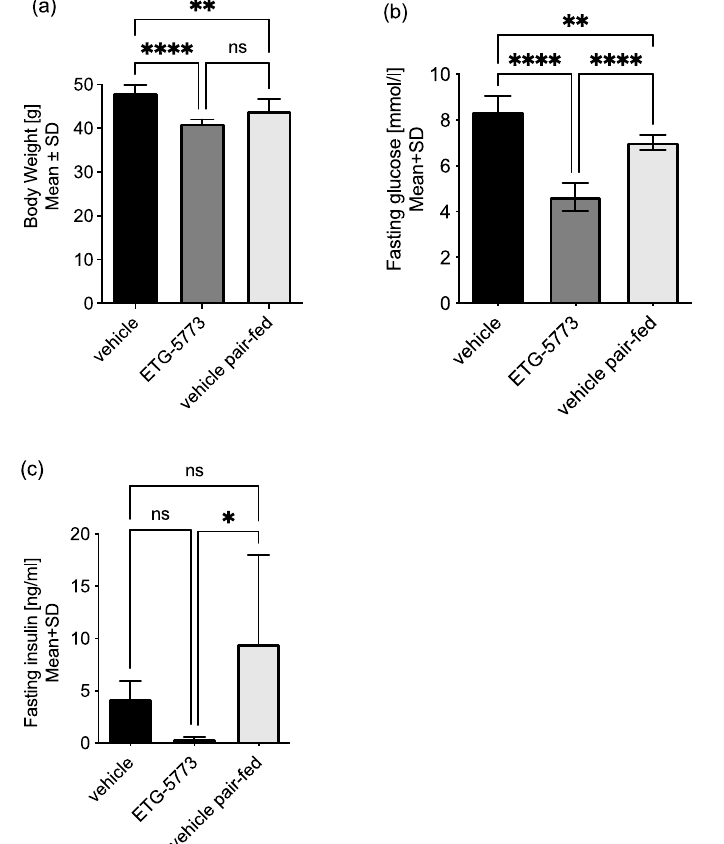
Figure 6. Body weight and glucose regulation in DIO mice treated with ETG-5773 for 7 days. ( a ) Body weight; ( b ) fasting blood glucose concentrations; ( c ) fasting serum insulin concentrations. Animals were treated orally twice a day with 15 mg/kg ETG-5773 or with the corresponding vehicle or vehicle in the pair-fed group. * p < 0.05, ** p < 0.01, **** p < 0.0001 as indicated, ns: non-significant. ANOVA mean SD, n = 6.